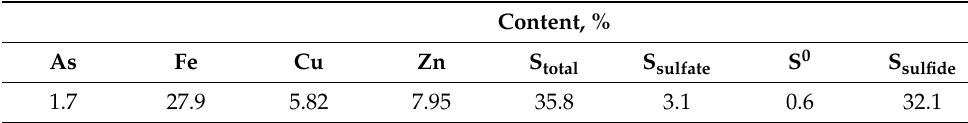
Table 1. Main element contents in the